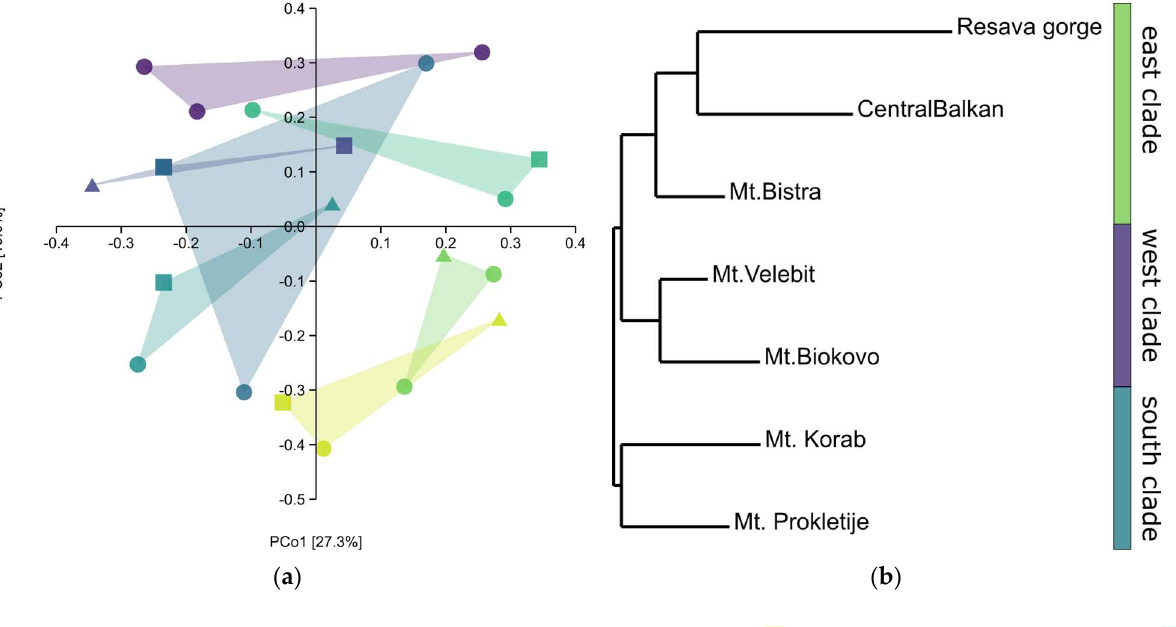
Figure 5. ( a ) PCoA scatter plot (Jaccard’s distances), − Central Balkan, − Resava gorge, − Mt. Bistra, − Mt. Korab, − Mt. Prokletije, − Mt. Biokovo, − Mt. Velebit; triangles − sab- inene chemotype, squares − intermediate chemotype, dots − trans -sabinyl acetate chemotype; ( b ) NJ tree, Nei’s genetic distances.